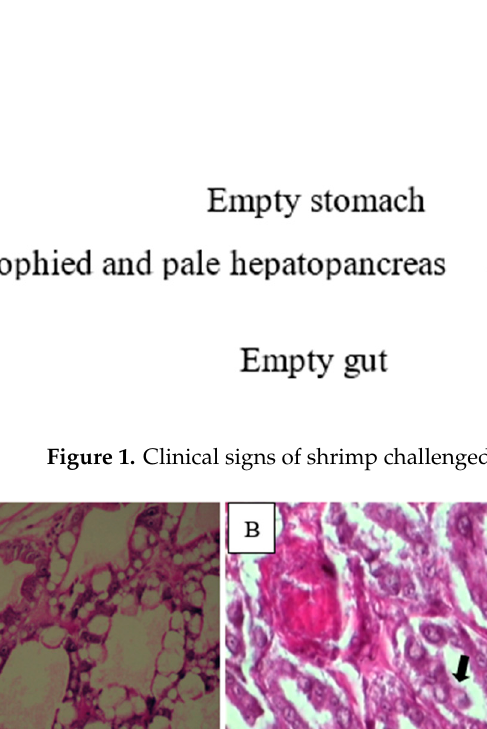
Figure 2. Histopathology of shrimp hepatopancreas (HP). Unchallenged shrimp showed normal structure of shrimp HP ( A ). Challenged shrimp showed sloughing of HP tubule epithelial cells (( B ), Table 3. Antimicrobial resistances of Vp AHPND strains ( n = 16). arrows), sloughing and necrosis of tubule epithelial cells (( C ), arrow) and hemocytic infiltration surrounding HP tubules (( C ), arrowhead). H&E stain. Magnification 400X. Scale bars = 50 µm.